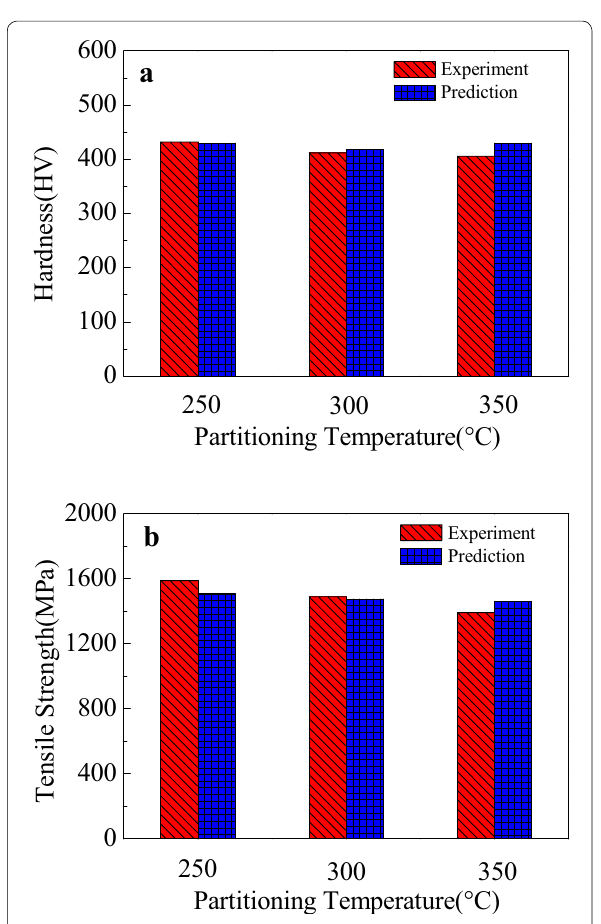
Figure 8 Comparison between predicted and experimental results for Q&P hot stamping: a hardness; b tensile strength